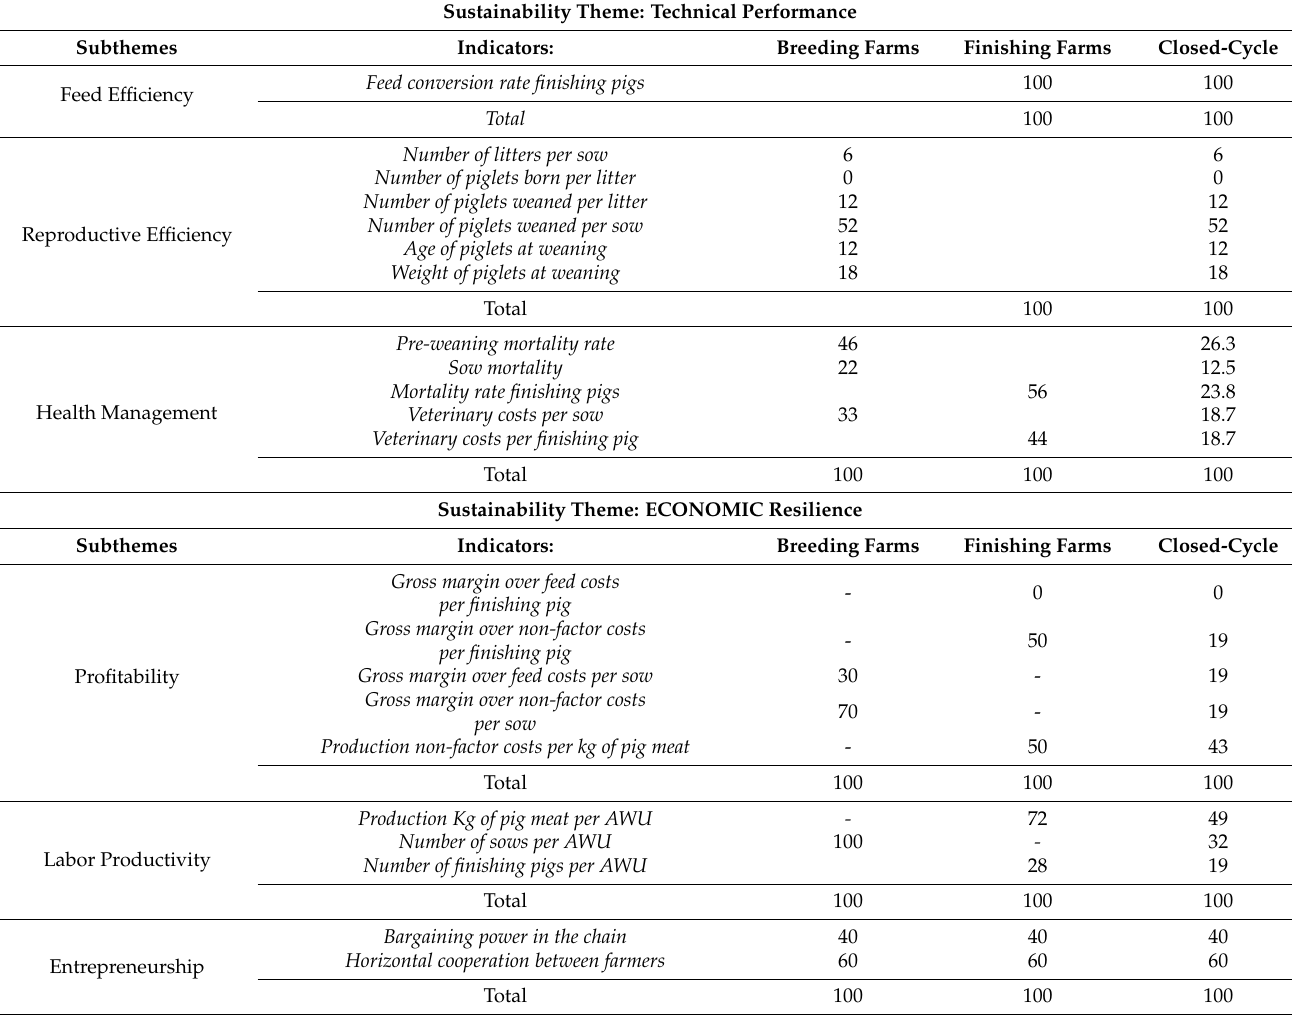
Table A2. Weights used in aggregation of indicators into subthemes of economic